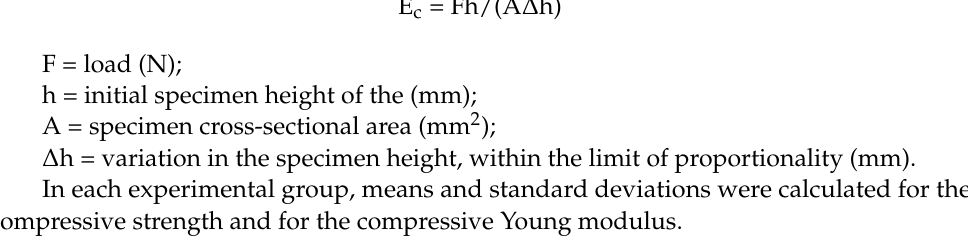
Figure 4. G-PMMA specimen ready to be subjected to compressive load in a universal testing machine.